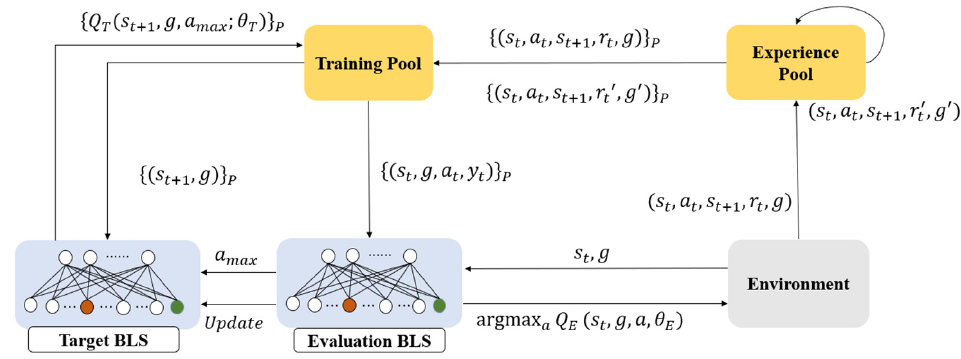
Figure 3. DBRL-HER algorithm structure diagram.